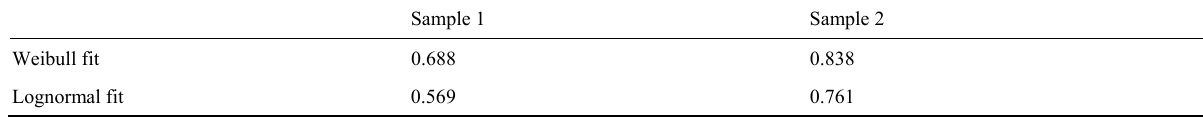
Table 3: P-values in the Kolmogorov-Smirnov goodness-of-fit test